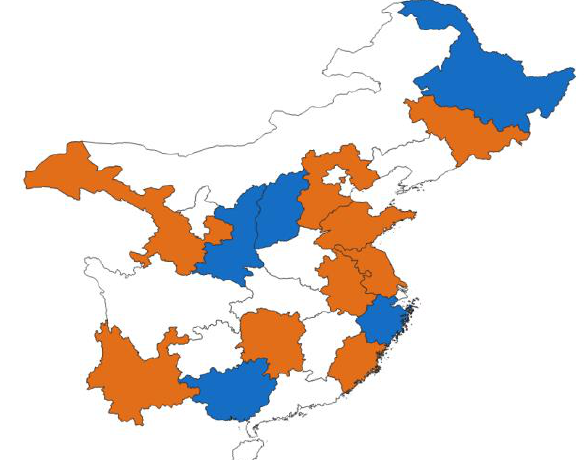
Figure 1. Research area in China (rice yield increasing areas in orange and decreasing areas in blue,